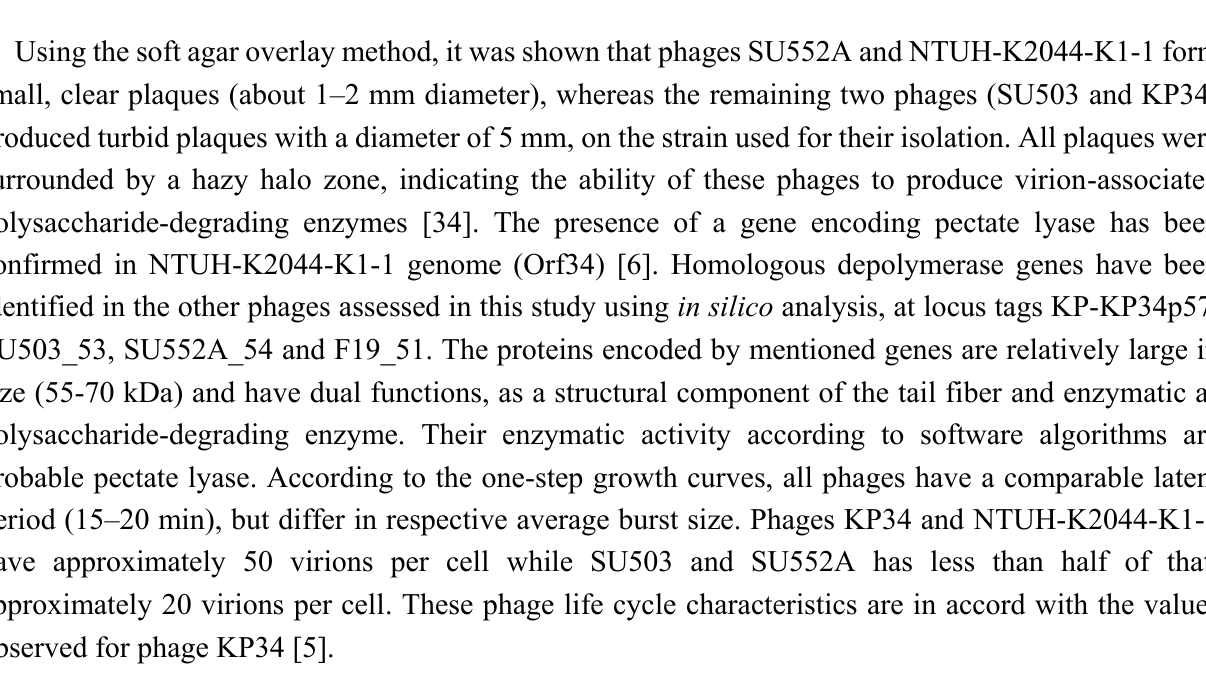
Figure 1. Transmission electron micrographs of ( A ) SU503; ( B ) SU552A; ( C ) KP34; ( D ) NTUH-K2044-K1-1. Length bar is 100